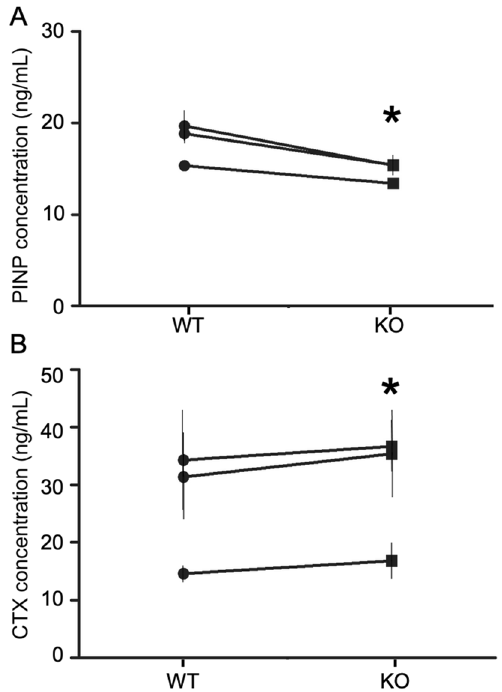
Figure 7. PINP and CTX levels in 18-month-old wild-type and Hyal1 −/− mice. PINP (Procollagen type I N-terminal propeptide) ( a ) and CTX (C-Terminal Telopeptide of type I-collagen) ( b ) levels were quantified using ELISA assays in 18-month-old mice from both genotypes. Three independent series of mice (with n ≥ 4 for each genotype) were included in three separate experiments. Paired means ± SEM are shown in the graphs for each experiment. *p < 0.05. Paired